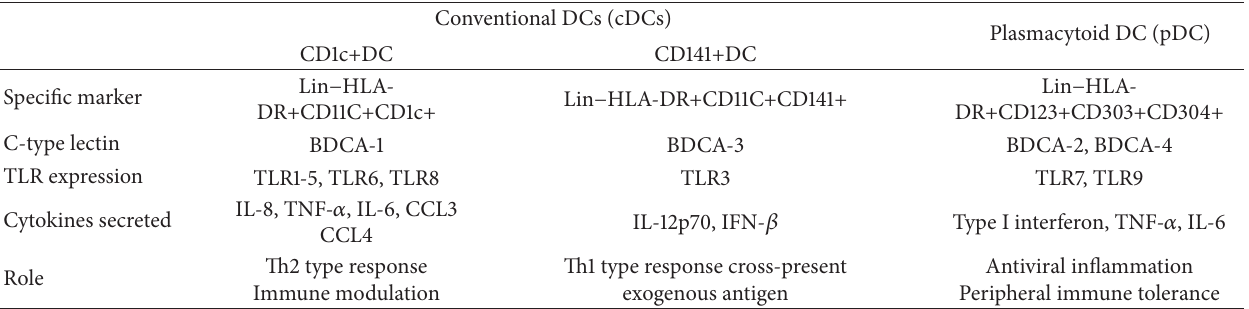
Table 1: Human dendritic cell